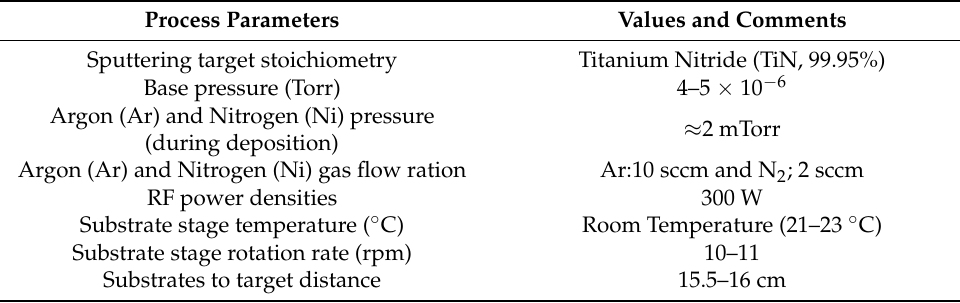
Table 1. Summary of the process parameters and conditions used to prepare the TiN thin film layers on various